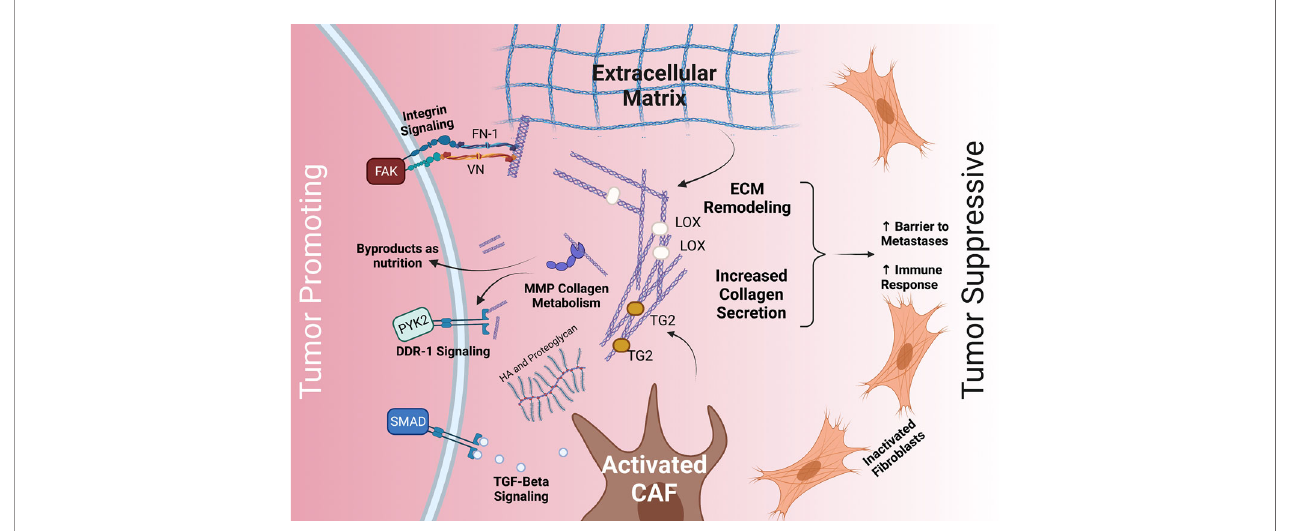
FIGURE 1 | The dichotomous role of the stroma and common interactions between PDAC tumor cells, the ECM, and CAFs. The stroma ’ s ECM plays both a tumor promoting role (left) and a tumor suppressive role (right). Tumor promoting roles may include integrin, TGF b /SMAD, and DDR-1 signaling, as well as providing nutrition via collagen fragments. Tumor suppressive roles may include providing a barrier to metastases and increasing immune response. The ECM (middle) is deposited by CAFs and modulated by MMP, LOX, TG2, HA, and others. CAF, cancer associated fi broblasts; TGF- beta, transforming growth factor beta; HA, hyaluronan; FN-1, fi bronectin 1; VN, vitronectin; DDR-1, discoidin receptor 1; PYK2, FAK-related protein tyrosine kinase; FAK, focal adhesion kinase; TG2, tissue transglutimase; LOX, lysyl